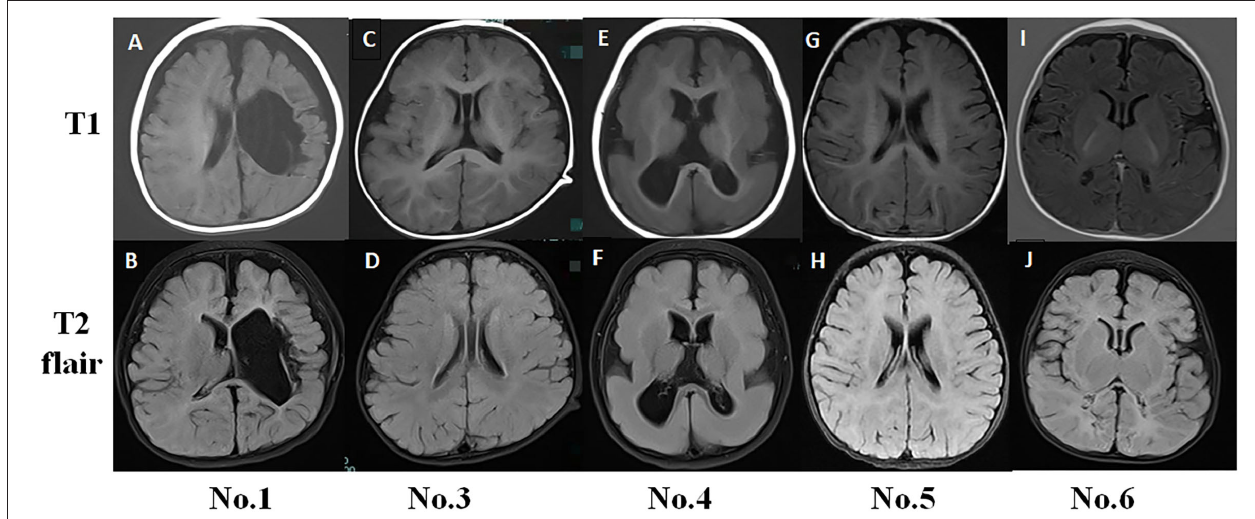
FIGURE 1 | Typical magnetic resonance imaging (MRI) findings in infantile spasm (IS) patients. (A,B) No. 1 MRI (8-month-old) showed left hemisphere softening, left ventricle deformity, and cerebral peduncle atrophy. (C,D) No. 3 MRI (15-month-old) had normal findings. (E,F) No. 4 MRI (11-month-old) showed pachygyria. (G,H) No. 5 MRI (6-month-old) had normal findings. (I,J) No. 6 MRI (4-month-old) exhibited abnormal signals in the bilateral occipital and parietal